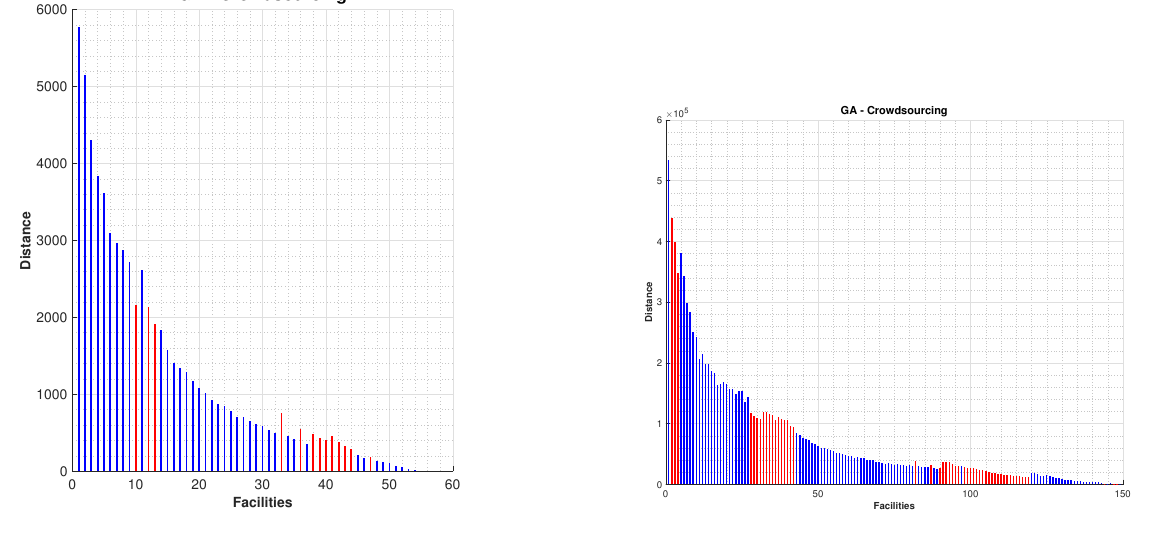
Figure 7. The Pareto set after solving the FLP complemented via crowdsourcing for: the Swain dataset ( left ), and the London dataset ( right